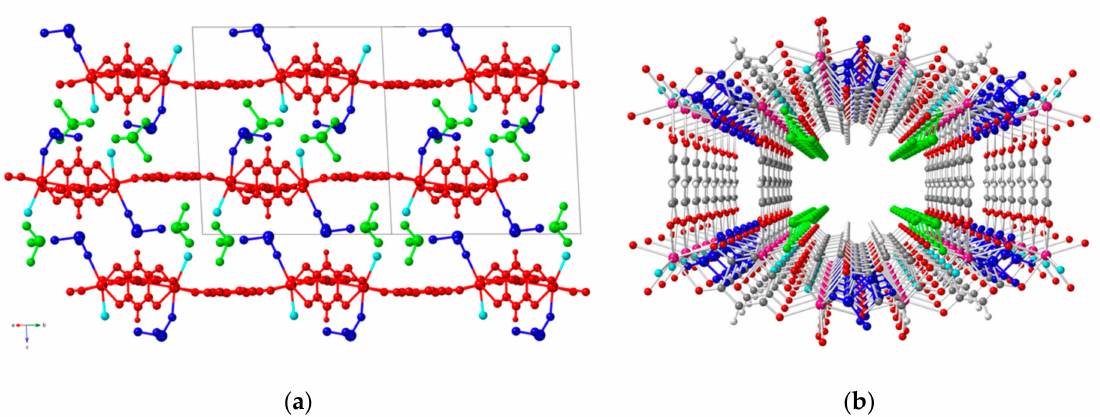
Figure 3. ( a ) Side view of three consecutive layers in compound 1 (in red) showing the coordinated dmso and water molecules (dark and light blue, respectively) and the crystallization dmso molecules (green); ( b ) Perspective view of two rectangular and one hexagonal channels in 1 along the c direction showing the crystallization dmso (in green) located in the hexagonal